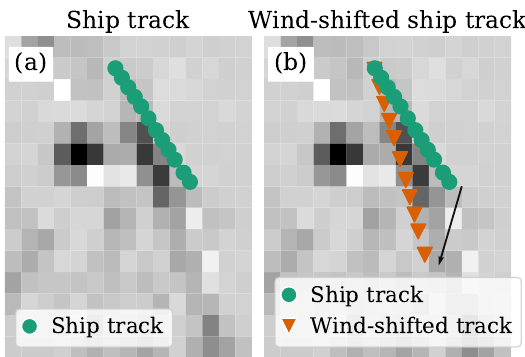
Figure 4. ( a ) Ship track —estimated, based on AIS data records. The ship track is shown for the time period starting from 2 h before the satellite overpass until the moment of the satellite overpass. ( b ) Wind-shifted ship track —a ship track shifted in accordance with the speed and direction of the wind. The wind-shifted ship track indicates the expected position of the ship plume. A black arrow indicates the wind direction. For both presented images, the size of the pixel is equal to 4.2 × 5 km 2